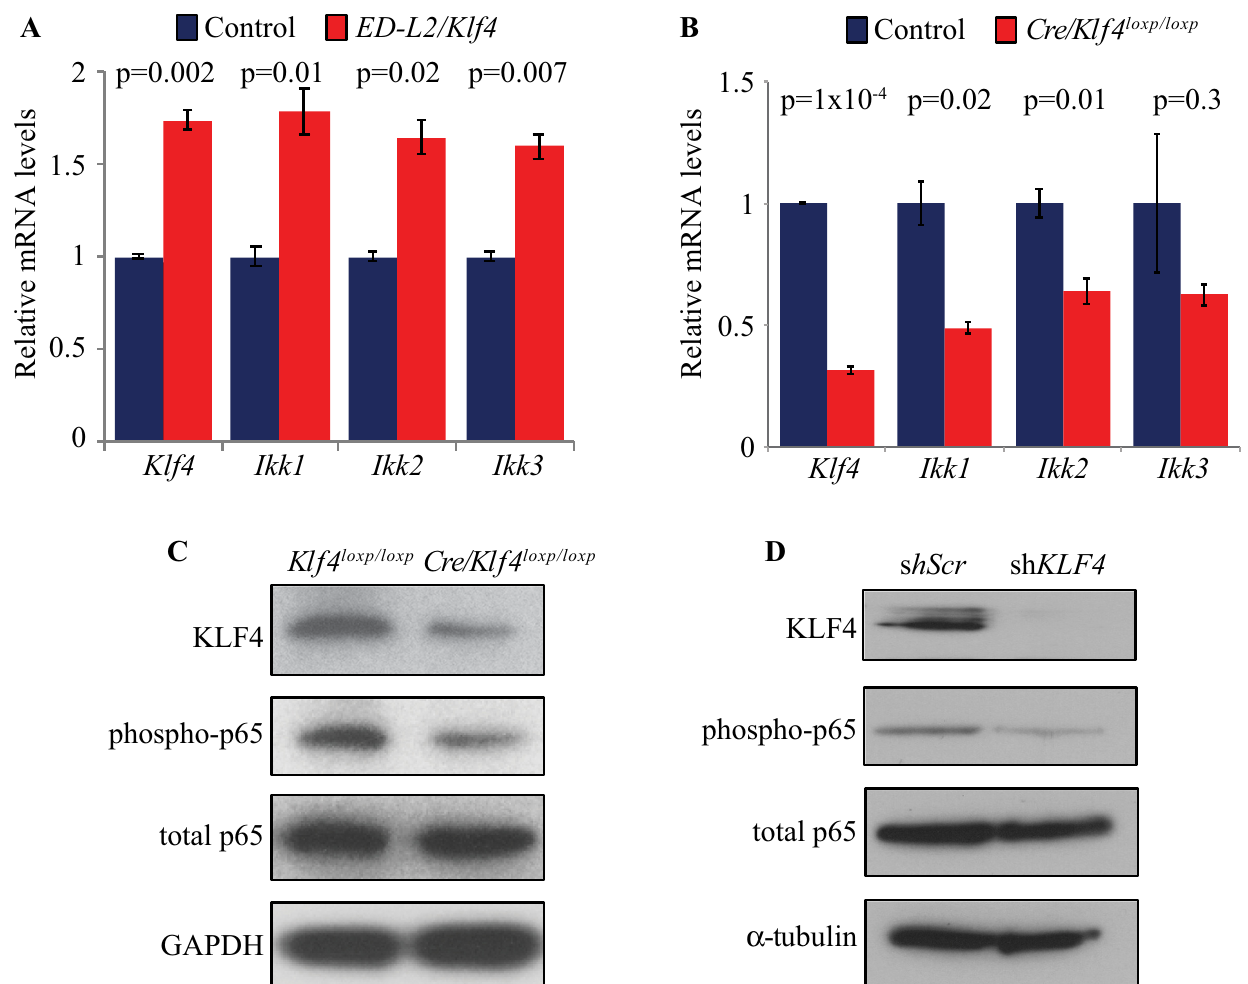
Fig 1. KLF4 activates NF κ B signaling in esophageal epithelial cells. ( A ) By qPCR, Ikk1 , Ikk2 , and Ikk3 expression was increased in primary esophageal keratinocytes from mice overexpressing Klf4 ( ED-L2/Klf4 mice) compared to keratinocytes from control mice. ( B ) By qPCR, expression of Ikk1 , Ikk2 , and Ikk3 was reduced in primary esophageal keratinocytes from mice with loss of Klf4 ( ED-L2/Cre;Klf4 loxp/loxp mice) compared to control keratinocytes from Klf4 loxp/loxp mice without Cre. ( C ) Compared to control keratinocytes from Klf4 loxp/loxp mice without Cre, primary esophageal keratinocytes from ED-L2/Cre; Klf4 loxp/loxp mice had less phosphorylated p65 on Western blots but no change in total p65. ( D ). Compared to a scrambled shRNA control (shSCR), shRNA directed against KLF4 reduced p65 phosphorylation in primary human esophageal keratinocytes, as seen on Western blot.